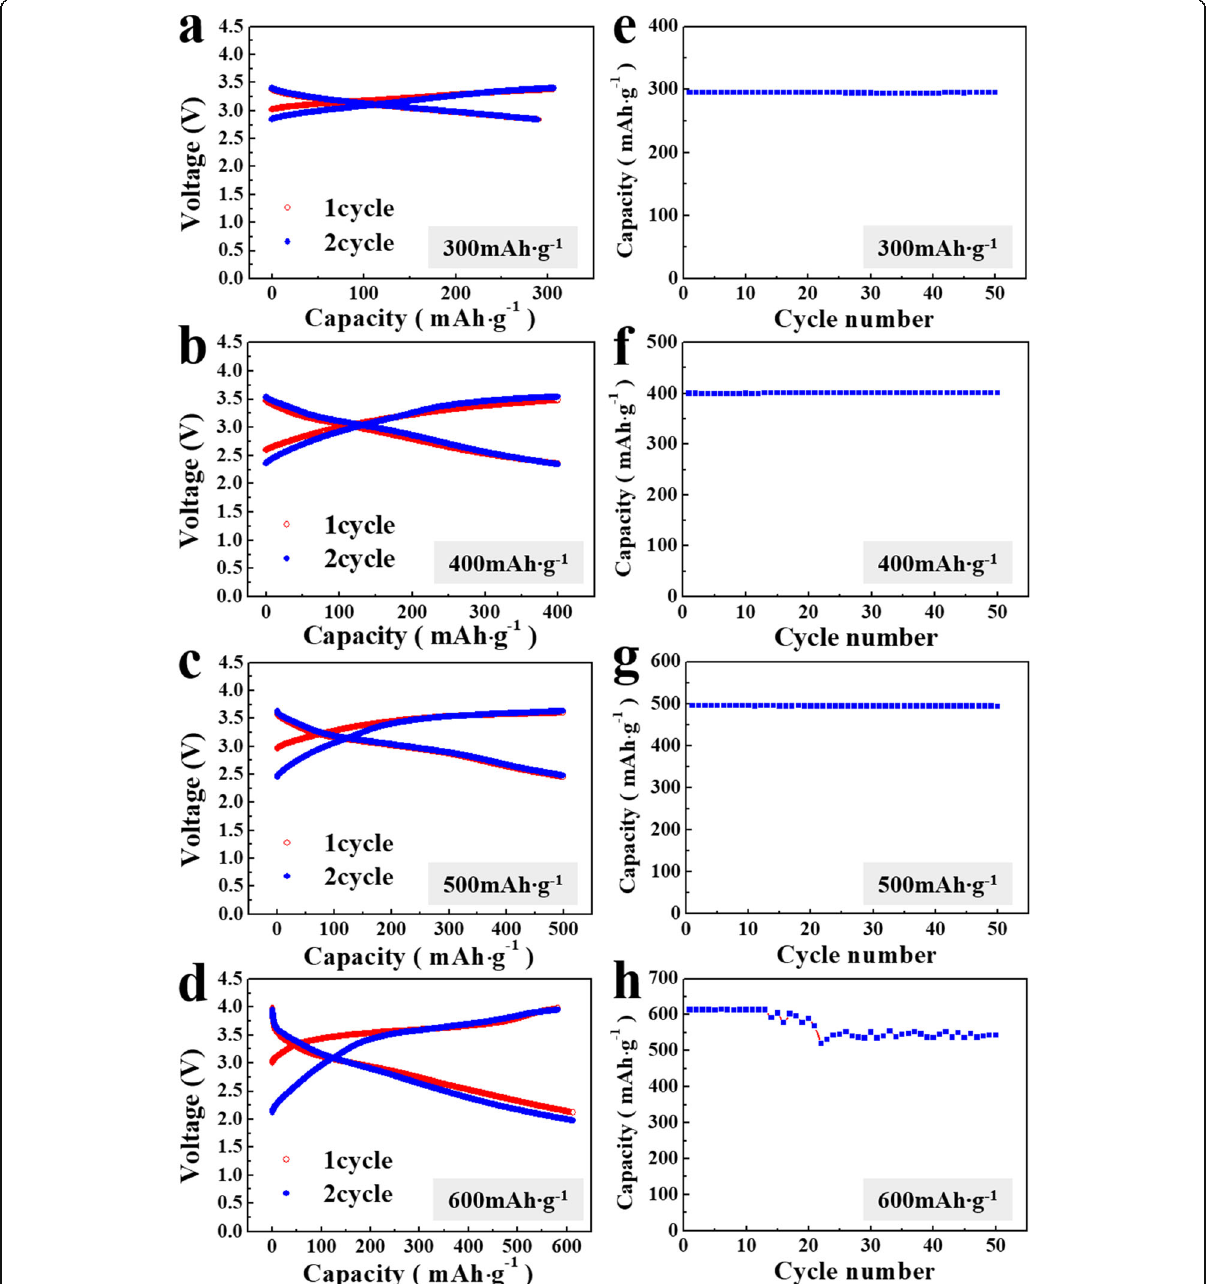
Fig. 2 Voltage curves of the lithia/Li 2 RuO 3 nanocomposites when the capacity is limited to a 300, b 400, c 500, and d 600 mAh g − 1 ; cycling when capacity limited is corresponding to e , f , g , and h ,